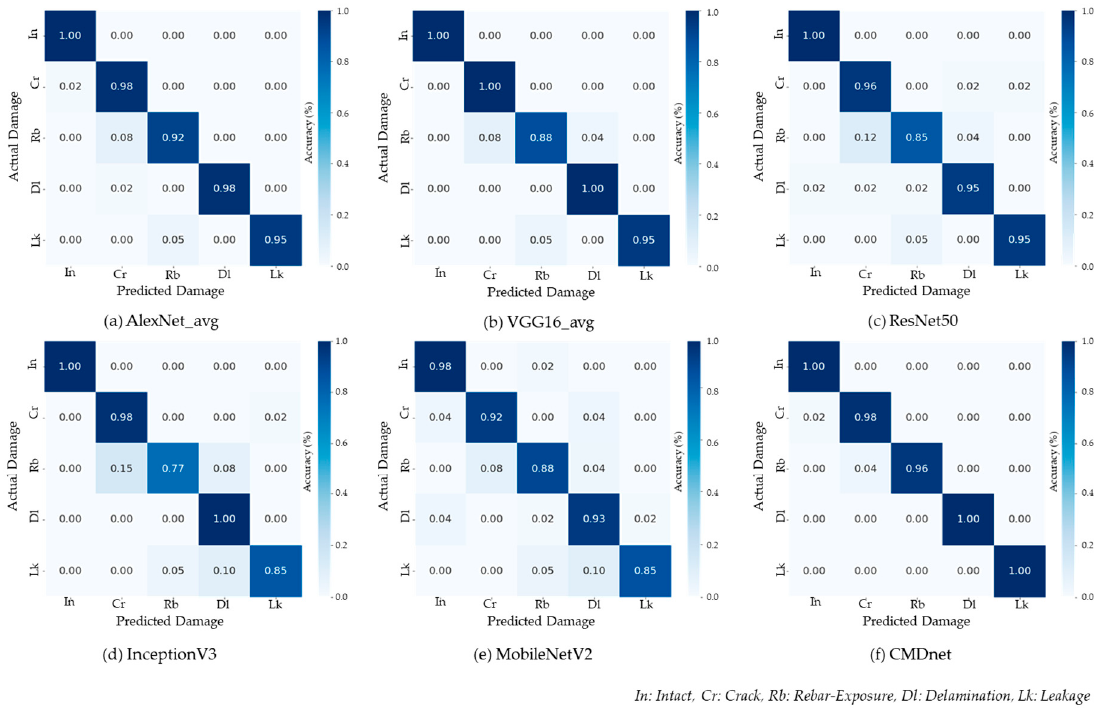
Figure 6. Normalized confusion matrices.